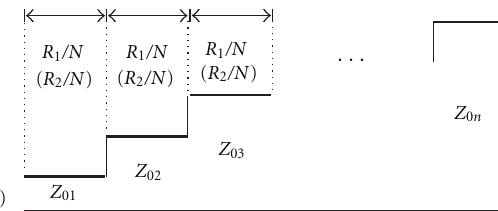
Figure 6: The equivalent transmission line model of the two pairs of symmetrical